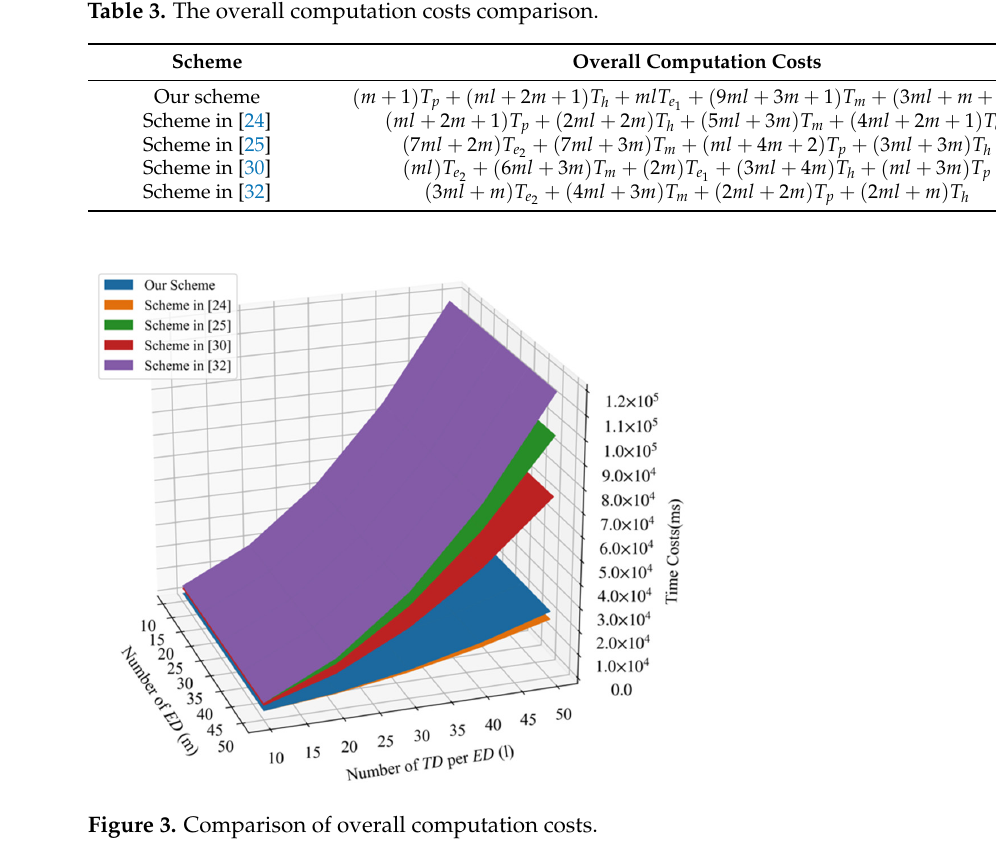
( b ) Figure 4. ( a ) Comparison of aggregation costs. ( b ) Comparison of signature and verification costs.